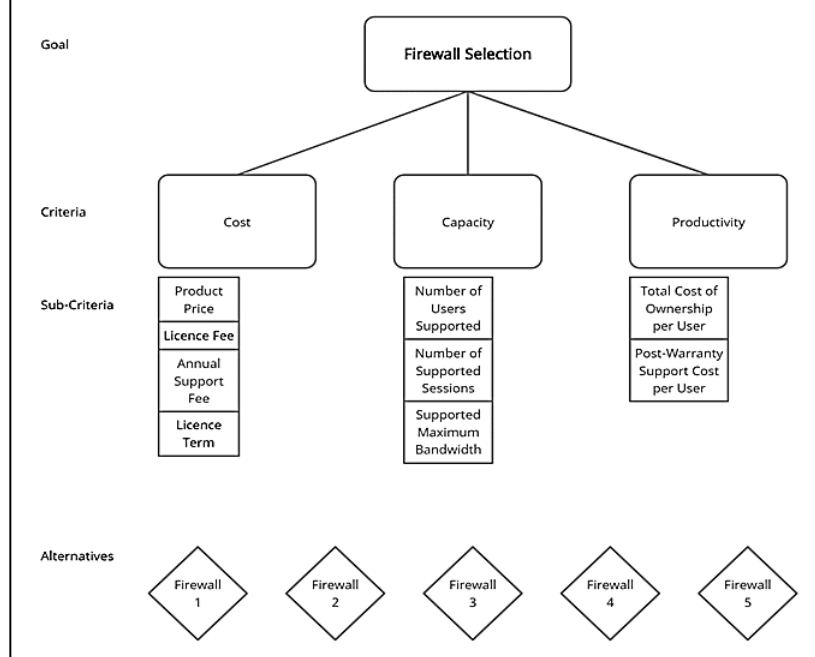
Fig. 1. Hierarchy for firewall service provider.